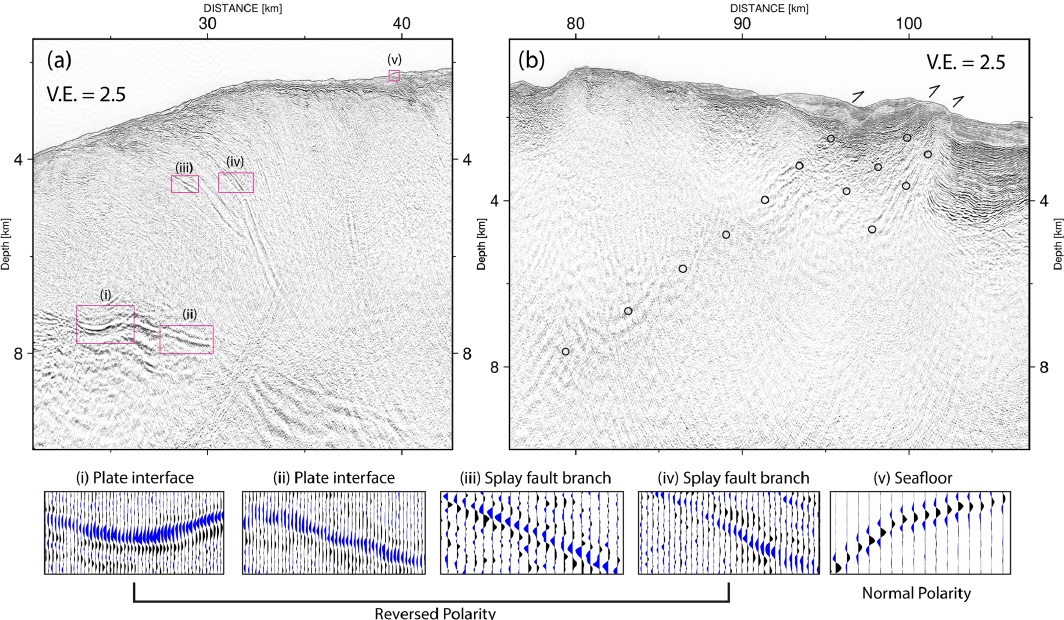
Figure 3. (a) Seismic section with a close-up view of the splay fault a (compare Fig. 2c for location) branching from the landward side of the subducting seamount. Red boxes indicate close-up views shown in the lower panels. Reversed polarity reflections (relative to the seafloor) are observed at the plate interface seaward of the seamount and along the splay fault. The black and blue colours present positive and negative wavelet polarity, respectively. (b) Seismic section with a close-up view of the back-thrust (compare Fig. 2c for location). Black circles mark the back-thrust fault